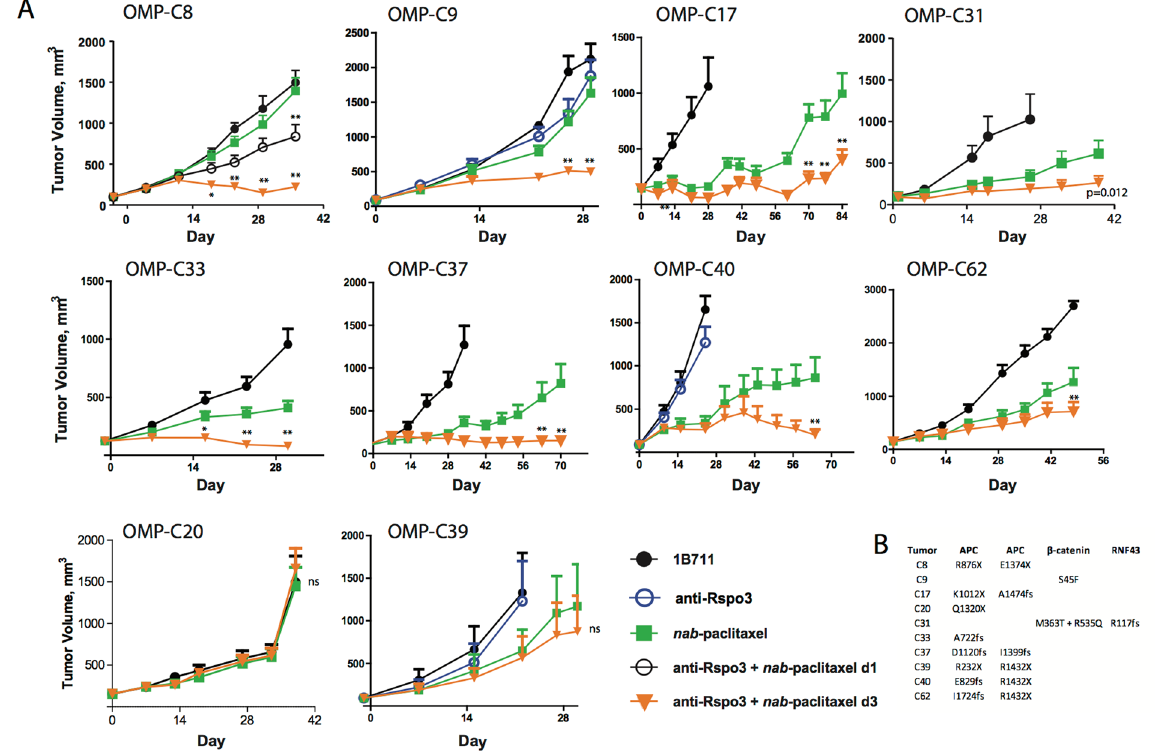
Figure 3. CRC PDX responds to Rspo3 antagonism in combination with taxane chemotherapy. ( A ) Eight of Ten CRC PDX models respond to taxane chemotherapy when anti-Rspo3 is dosed two days before nab - paclitaxel. anti-Rspo3 (25 mpk Q2W) dosed on day 1 and nab-paclitaxel (30 mpk Q1W) dosed on day 3 and day 10, in two week cycles is an active dosing regimen, n = 7–10 per treatment group, expressed as mean + SEM. * p < 0.01 vs. nab -paclitaxel, ** p < 0.001 vs. nab -paclitaxel, ns = not significant. ( B ) CRC PDX models contain activating mutations in APC, β -catenin, or RNF43. Mutations were detected in tumor cells using Sanger